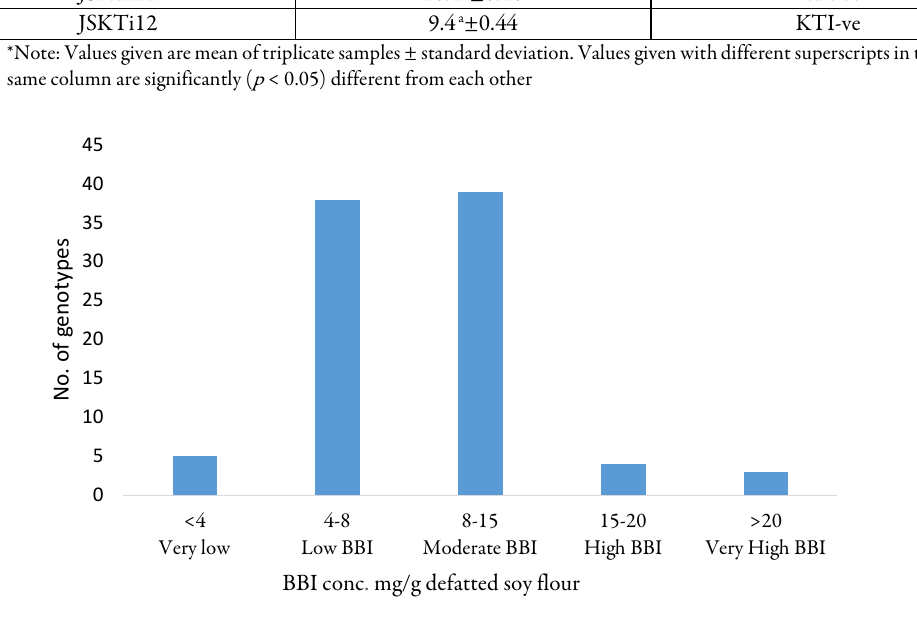
Figure 1. Distribution of 90 soybean varieties based upon varying BBI